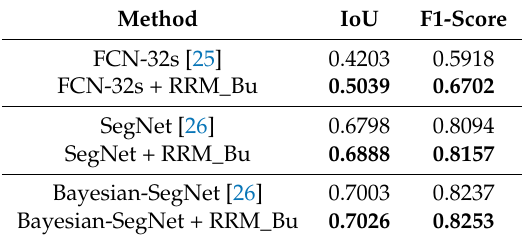
Table 4. Experimental results in migrating RRM_Bu to other